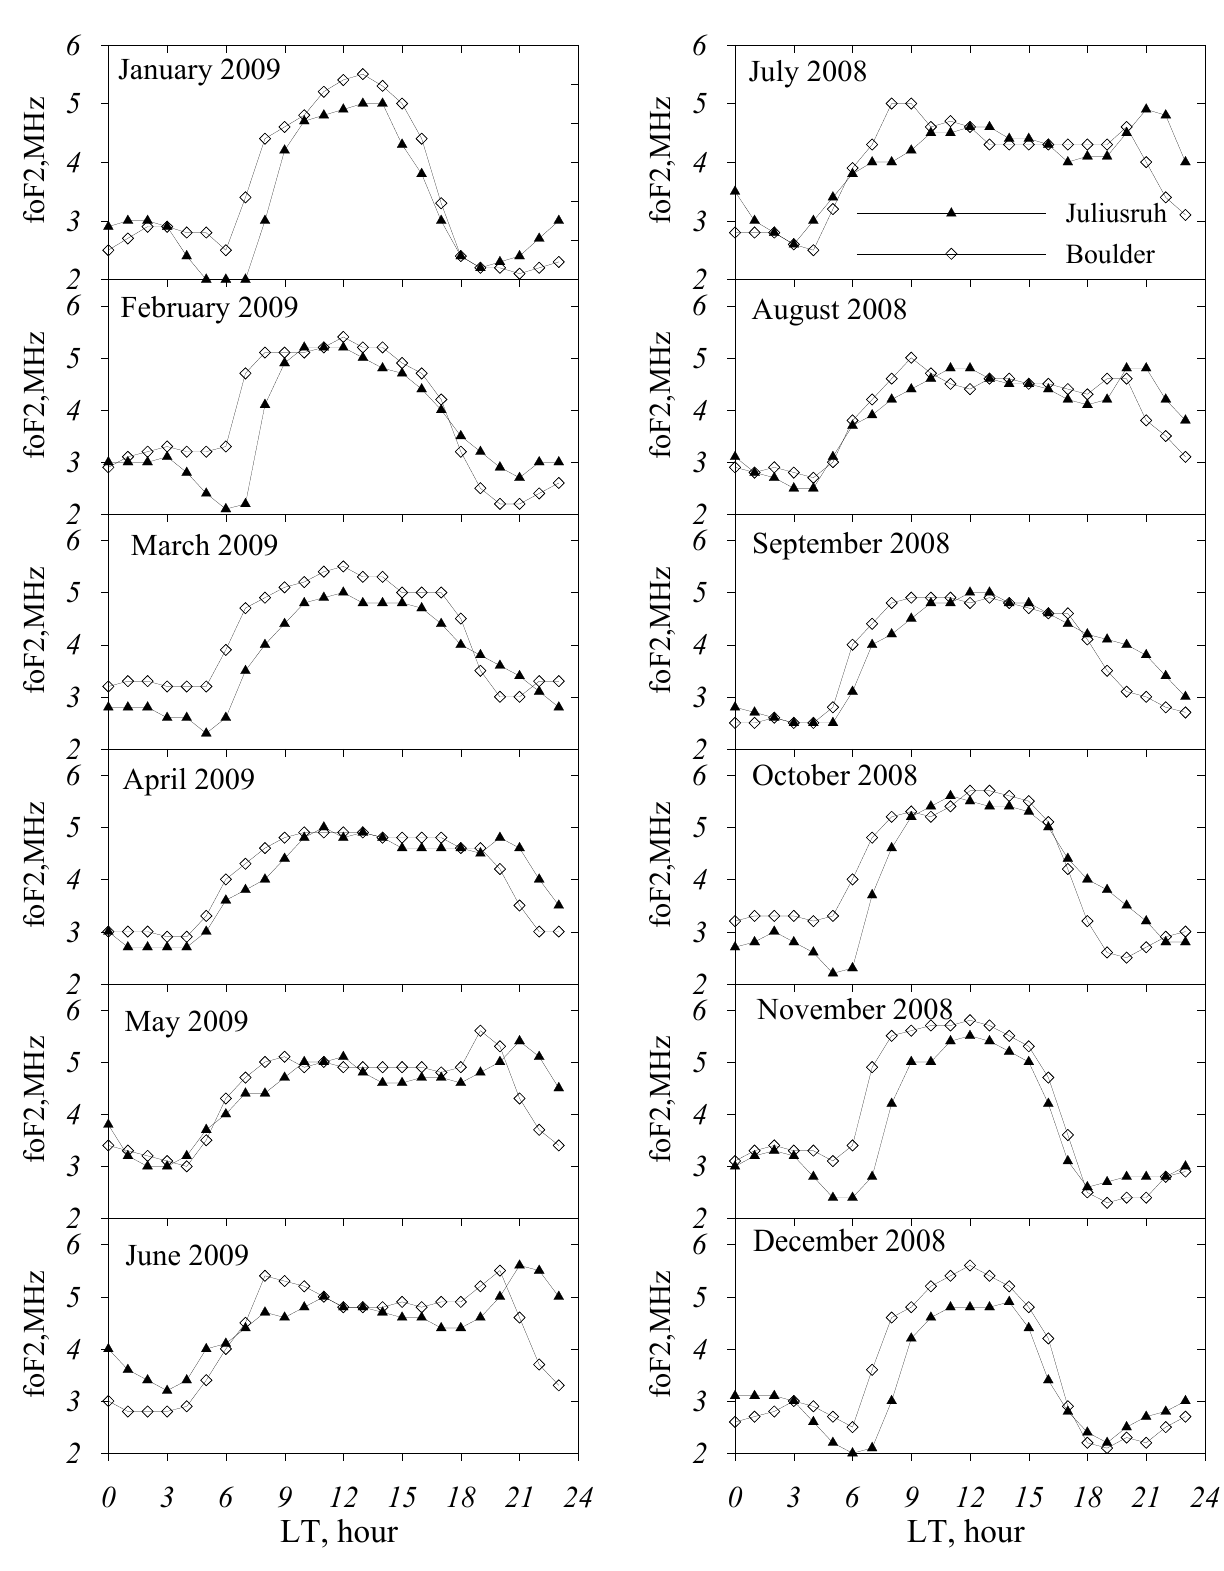
Figure 2. Monthly median foF 2 diurnal variations at Juliusruh and Boulder in 2008–2009. Our method [18] to retrieve thermospheric parameters from ionospheric observa- tions was applied to the selected dates in 2008 and 2009. The method utilizes observed noontime f o F 2 , plasma frequencies at 180 km height, f 180 for (10, 11, 12, 13, 14) LT, both observations may be taken from SAO fi les [20] at the stations where DPS-4 are installed. The method also uses neutral gas density as a fi tt ed parameter. CHAMP/STAR (h tt ps://isdc.gfz-potsdam.de/champ-isdc/, accessed on 15 March 2023) observations were